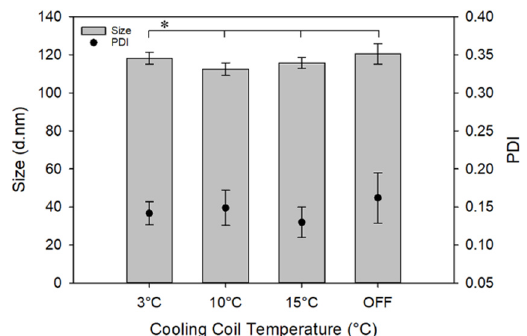
Figure 4. Effect of temperature of cooling coil on NP size and PDI. For this study, concentration and flowrate of the PLGA solution (organic stream) was 5 mg/mL and 3.5 mL/min, and that of the PVA solution (aqueous stream) was 10 mg/mL and 25 mL/min, respectively. * No statistically significant difference in the size or PDI of NPs as a function of cooling coil temperature ( p > 0.05).